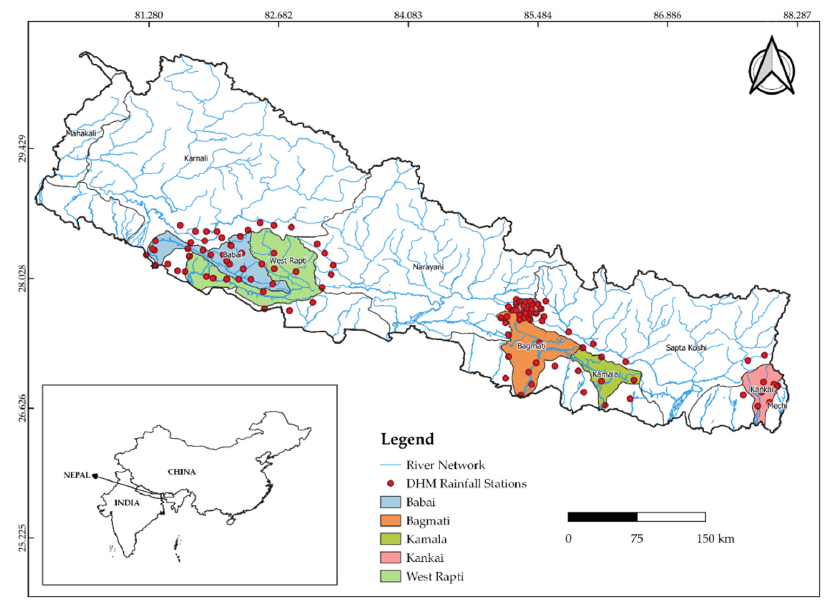
Figure 1. The study area map comprising of Babai, Bagmati, Kamala, Kankai, and West Rapti river basins. Table 1. Summary information on basins. Basin